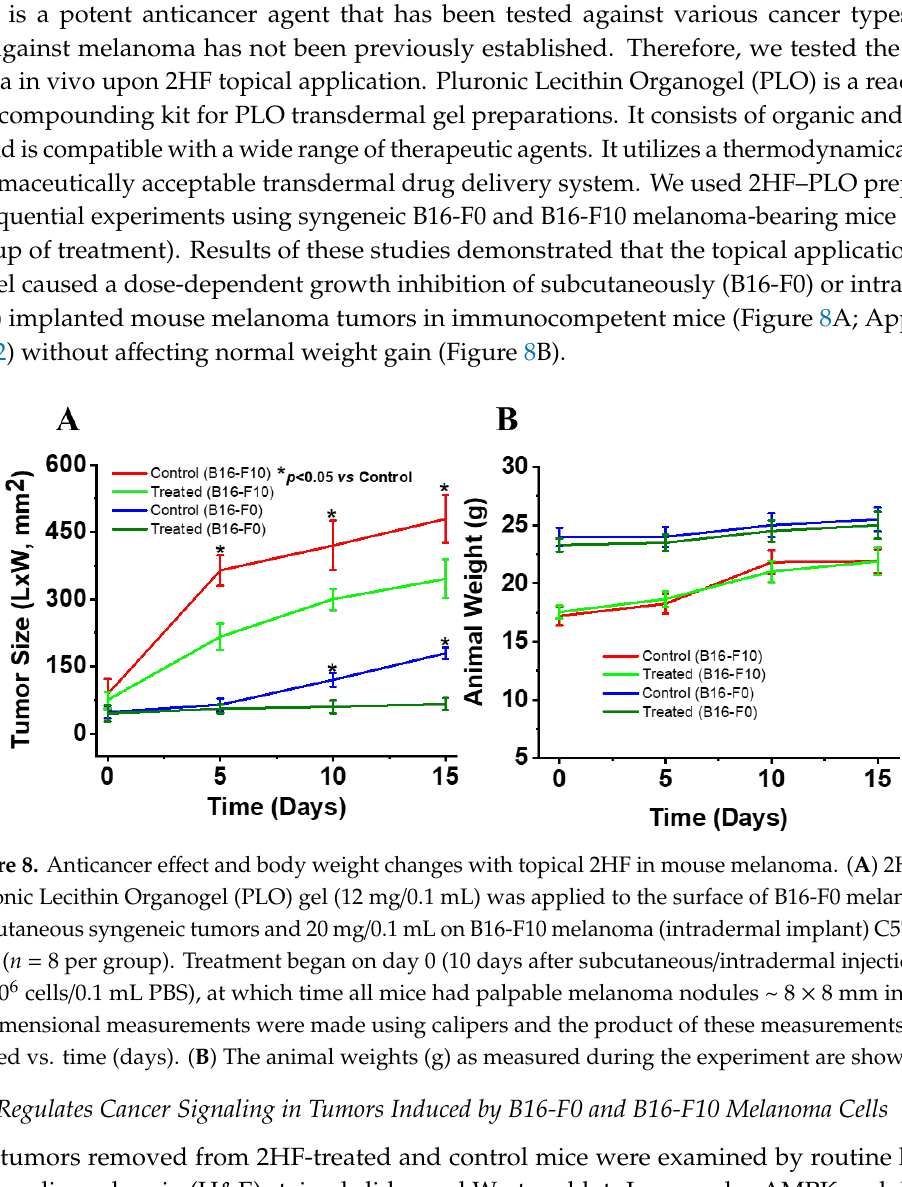
Figure 7. Plasma concentration vs. time profile of 2HF in rats. Mean plasma concentration vs. time profile of 2HF following intravenous and oral administration of 2HF at 5 mg/kg and 10 mg/kg, respectively, to male SD rats ( n = 3).